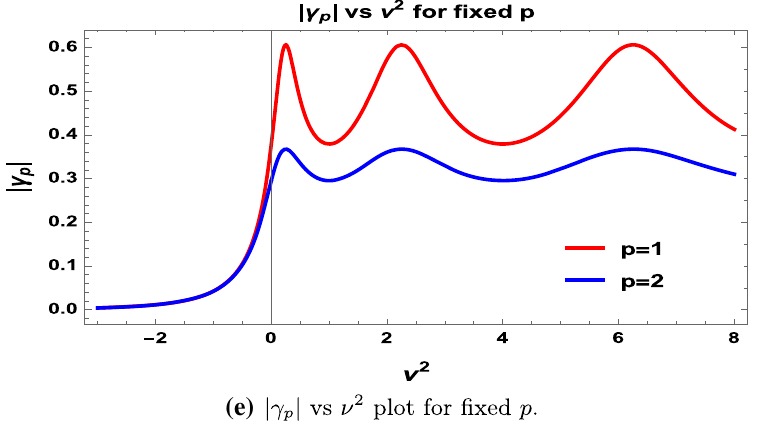
Fig. 5 Behaviour of | γ p | in de Sitter space for ‘ + ’ branch of solution. This figure clearly shows that we cover both large and small mass limit